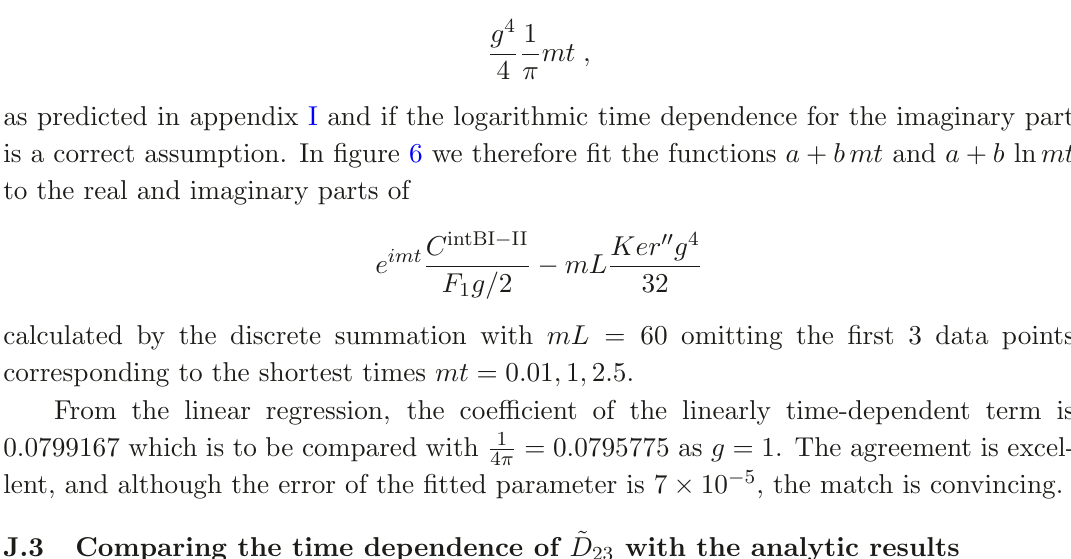
′′ g 4 mL Ker calculated by a discrete 32 F 1 g/ 2 −